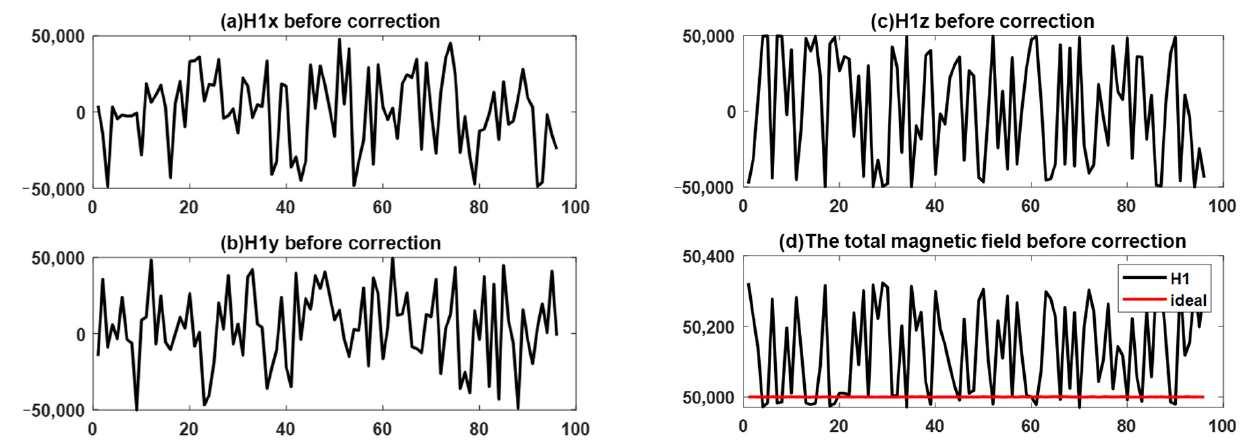
Figure 3. The components and total magnetic field of H1 before correction. ( a ) The component of the measured values of x -axis; ( b ) The component of the measured values of y -axis; ( c ) The component of the measured values of z -axis; ( d ) The total magnetic field of measured values and ideal values.